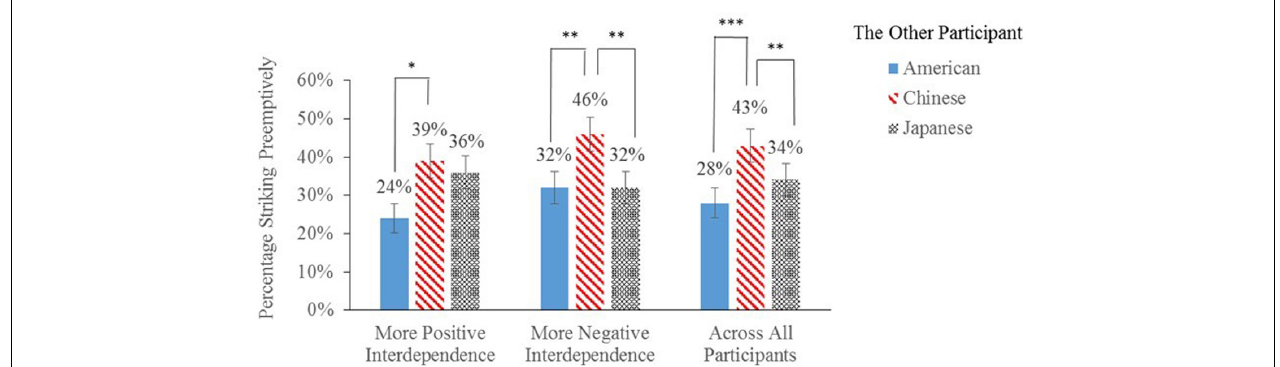
FIGURE 4 | Percentages of American participants striking preemptively ( ± 1 SE) in the red-button PSG, facing a different participant from each of the three countries and under different CNN media manipulations. More positive interdependence = Media portrayal of United States–China economic interdependence as more positive-sum. More negative interdependence = Media portrayal of United States–China economic interdependence as more zero/negative-sum. Participants completed the hypothetical United States–United States PSG before media manipulation, serving as the baseline for the effect of media framing on intergroup preemptive strikes. ∗ p < 0.05; ∗∗ p < 0.01; ∗∗∗ p ≤